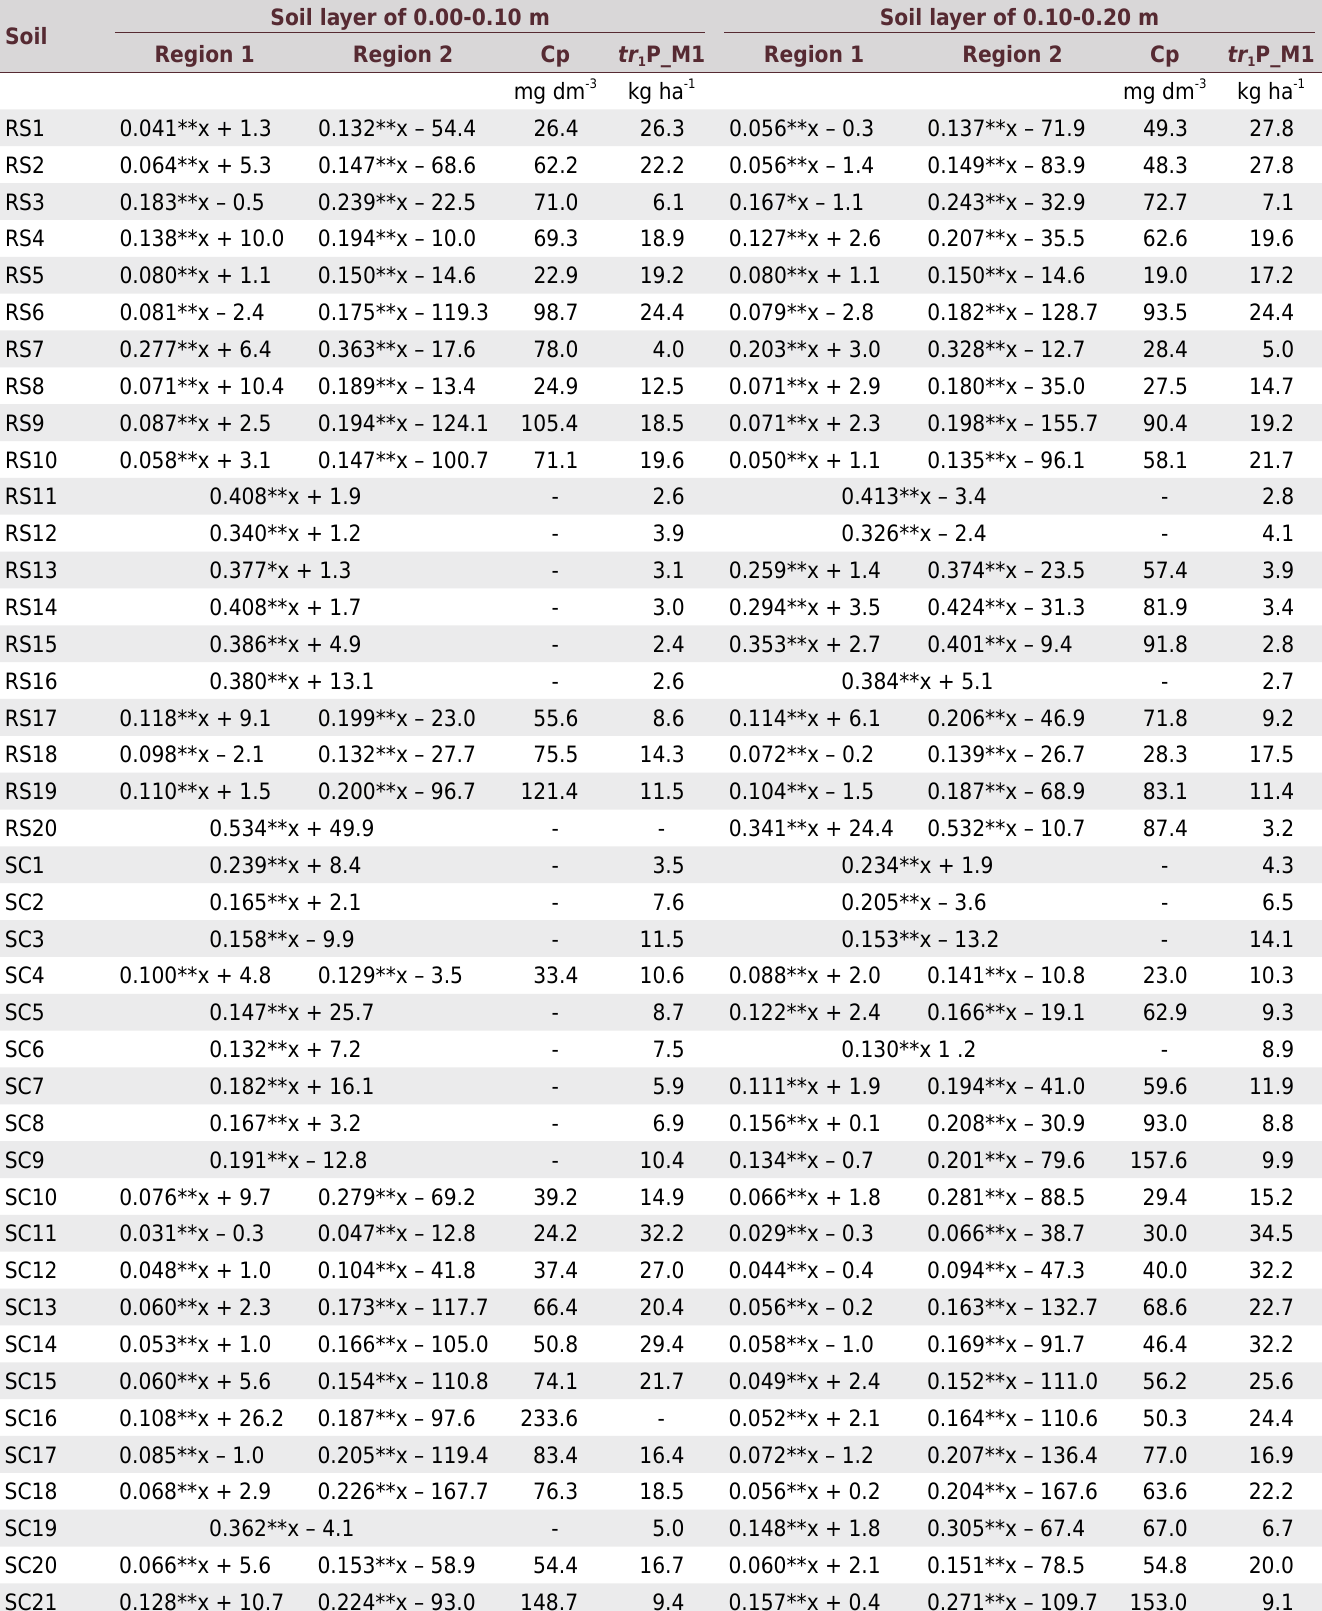
Table 2. Phosphorus extracted as a function of the 12 applied phosphorus rates, values of the change point (Cp) of the segmented equations, and values of tr 1 P_M1 in soil samples collected in the Rio Grande do Sul (RS) and the Santa Catarina (SC) States Soil layer of 0.00-0.10 m Soil